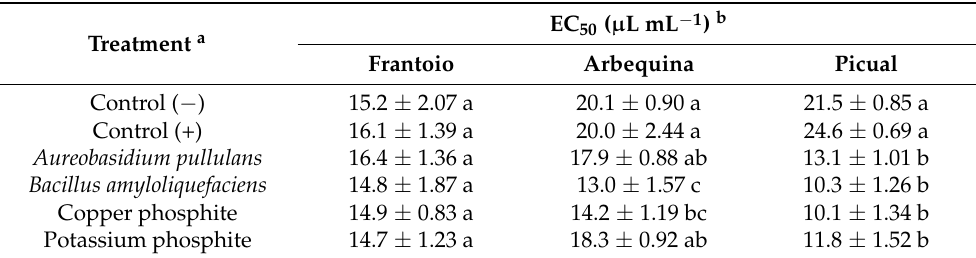
Table 3. Effective concentrations of olive stem extract (OSE) from cvs. Frantoio, Arbequina, and Picual and treated with the most effective compounds to inhibit 50% of conidial germination (EC 50; µ L mL − 1 ) of Verticillium dahliae isolate